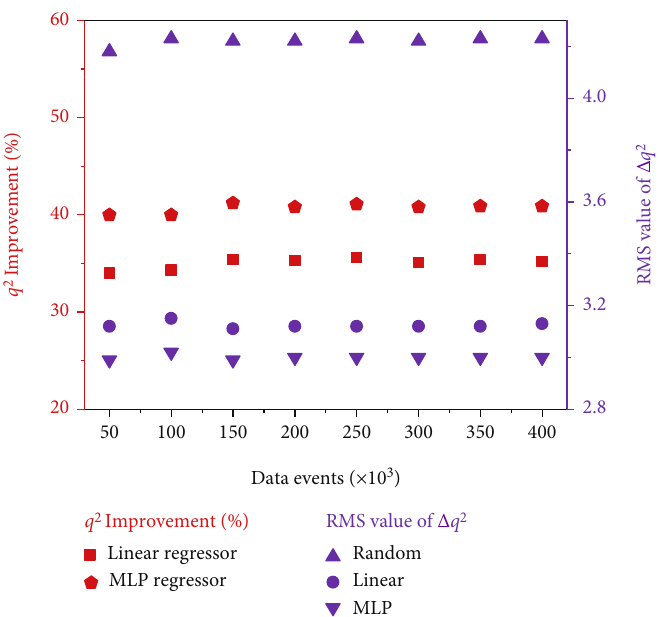
Figure 7: The improvement of reconstructed q 2 resolution and the RMS value of Δ q 2 with di ff erent numbers of data